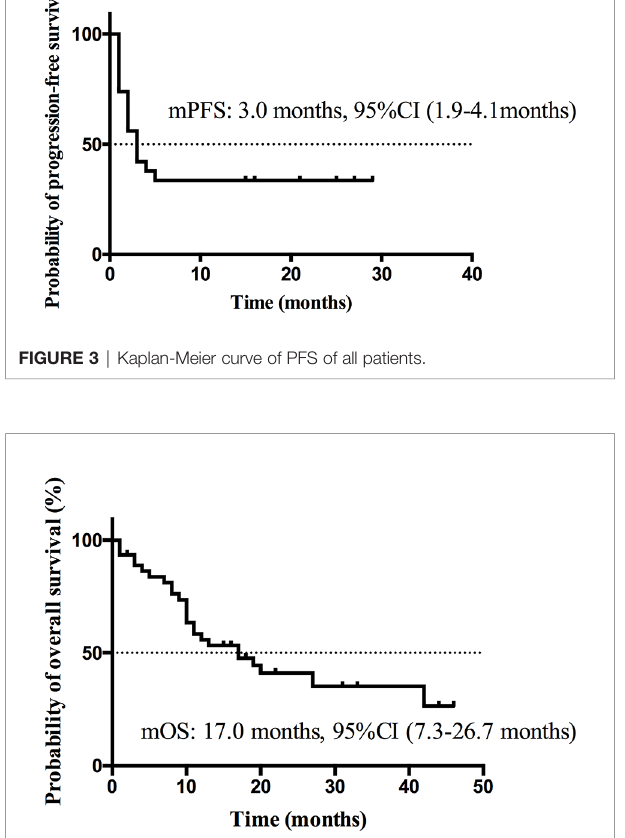
FIGURE 4 | Kaplan-Meier curve of OS of all patients.